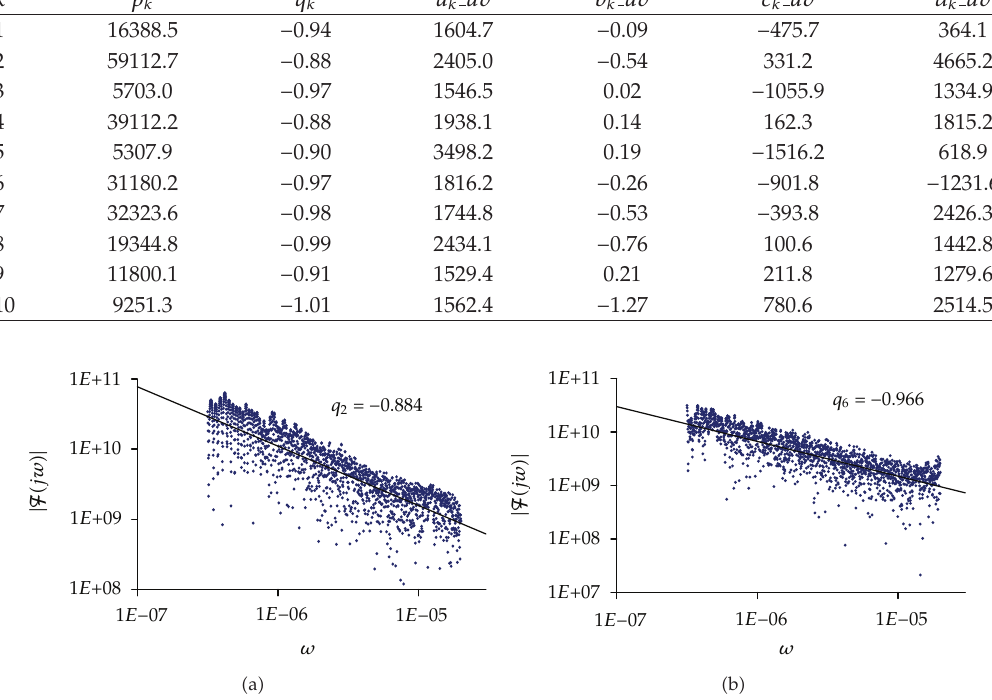
Figure 2: | FT { x k (cid:2) t (cid:3) }| and the power trendline p k ω q k for the indices Dow Jones (cid:2) a (cid:3) and Nikkei (cid:2) b (cid:3)